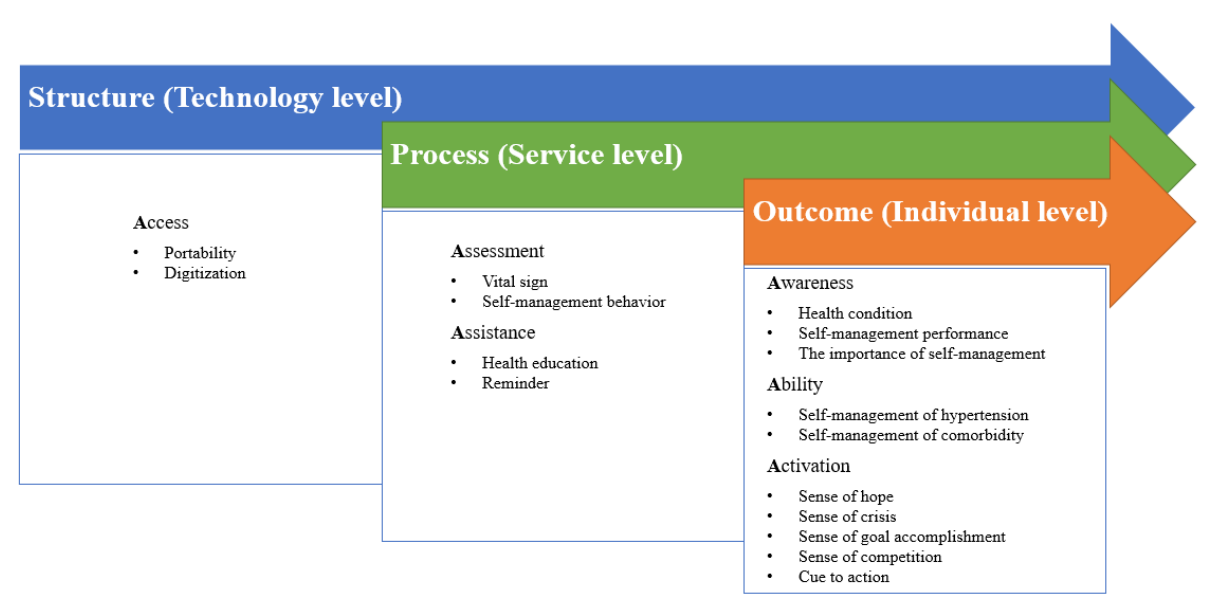
Figure 3. Interactions among the structure (access), process (assessment and assistance), and outcome (awareness, ability, and activation) in the mobile health service for hypertension